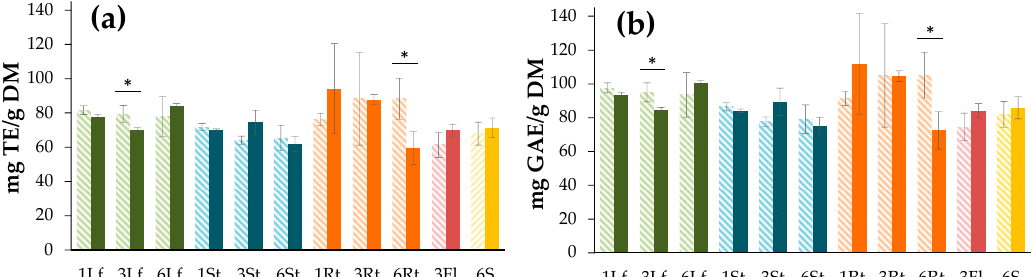
Figure 3. DPPH • free radical scavenging assay of C. quinoa processed by air-drying (dash bars) and freeze-drying (dark bars) at different times after seeding (1, 3, 6 months) of different plant parts (leaves (Lf), stems (St), roots (Rt), seeds (S), and flowers (Fl)). Each bar represents the mean ± standard deviation ( n = 3). No significant differences were found between treatments ( p = 0.25 > 0.05). ( a ) Trolox as standard, ( b ) gallic acid as standard. * p < 0.05 when compared between drying methods.